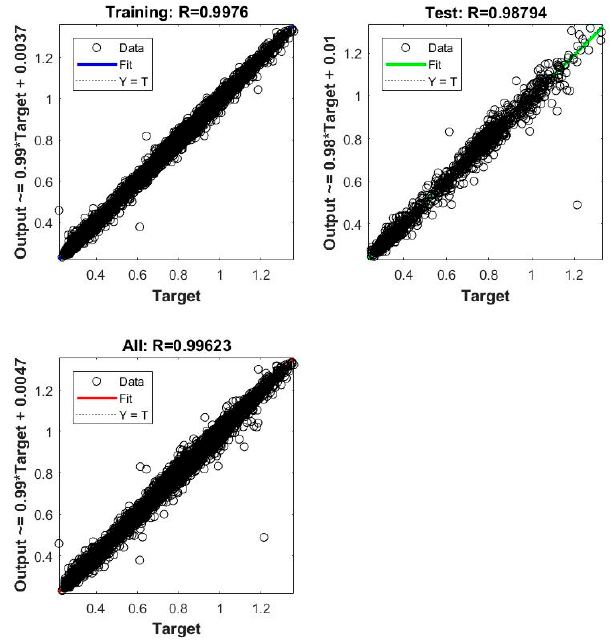
Figure 17. The regressions between the network targets and network outputs when forecasting the electricity consumption for the month of December, using the ANN_NARX_BR_TS network.